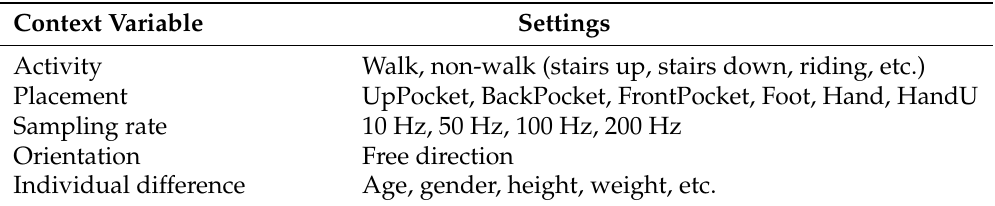
Table 3. The context variables in the